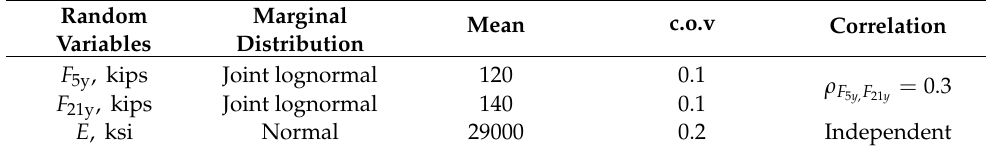
Table 10. Description of random variables for the truss structure optimization